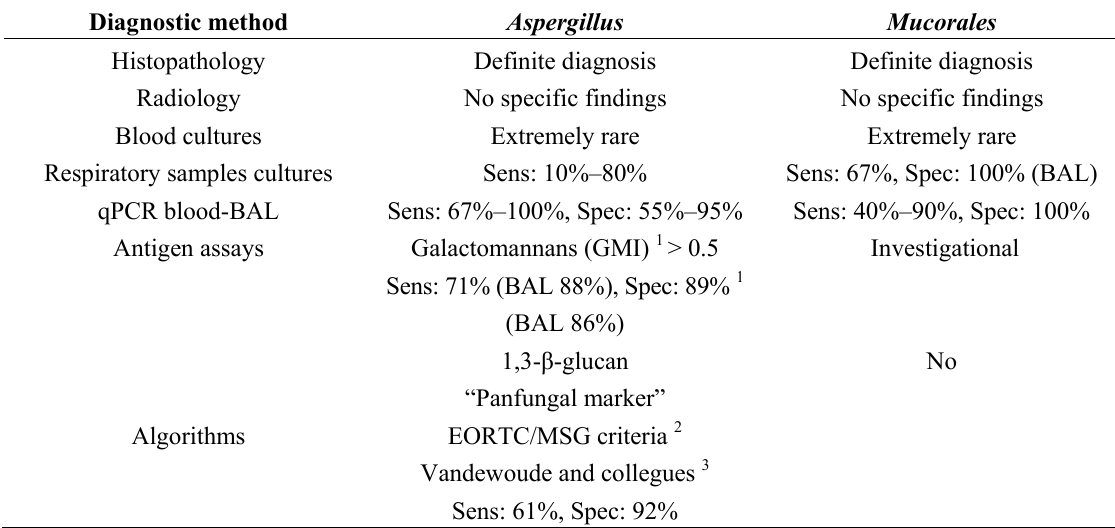
Table 4. Diagnostic approach for invasive Aspergillosis and Mucorales infections in the